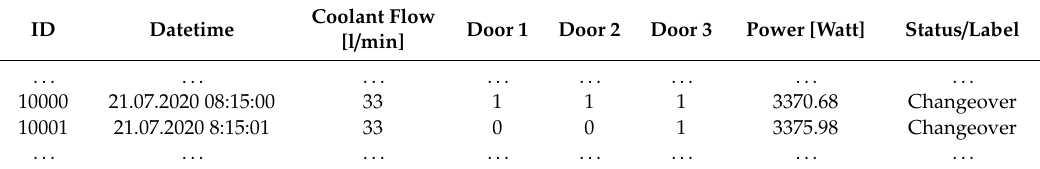
Table 11. Database excerpt.